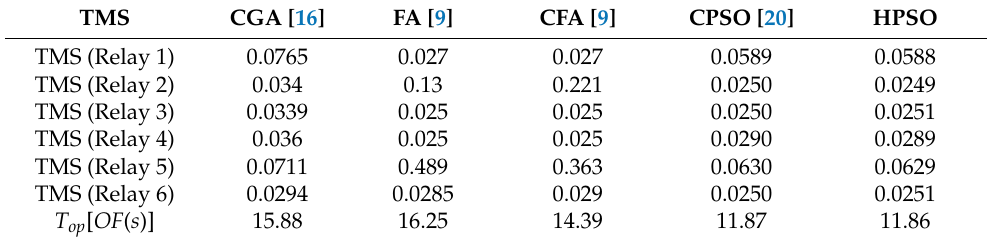
Table 13. Comparison of the optimized TMS with other techniques (case